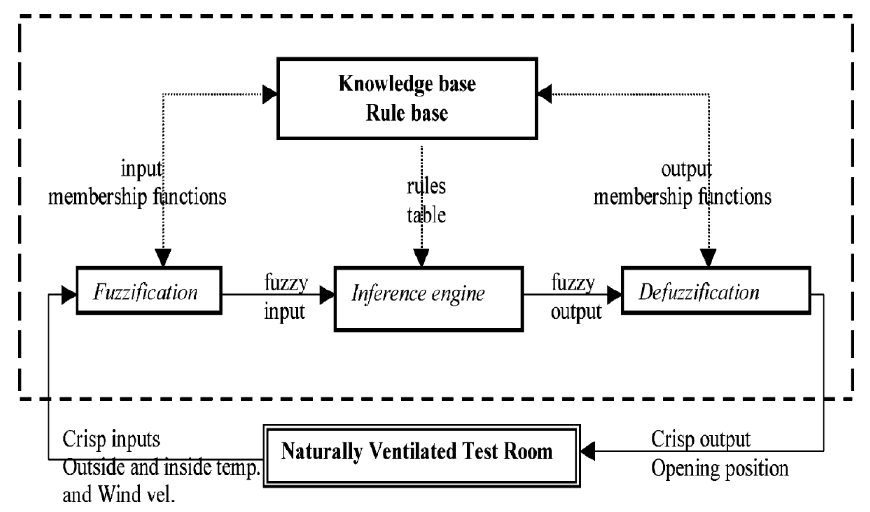
Figure 3. Basic configuration of fuzzy logic controller [57].